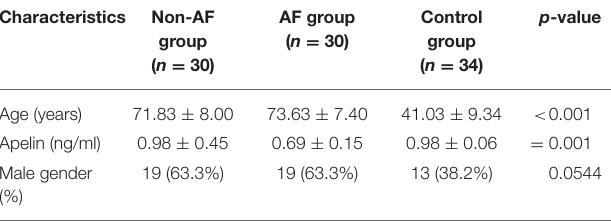
TABLE 2C | Patient characteristics: atrial fibrillation patients vs. non-atrial fibrillation patients vs. control group. Characteristics